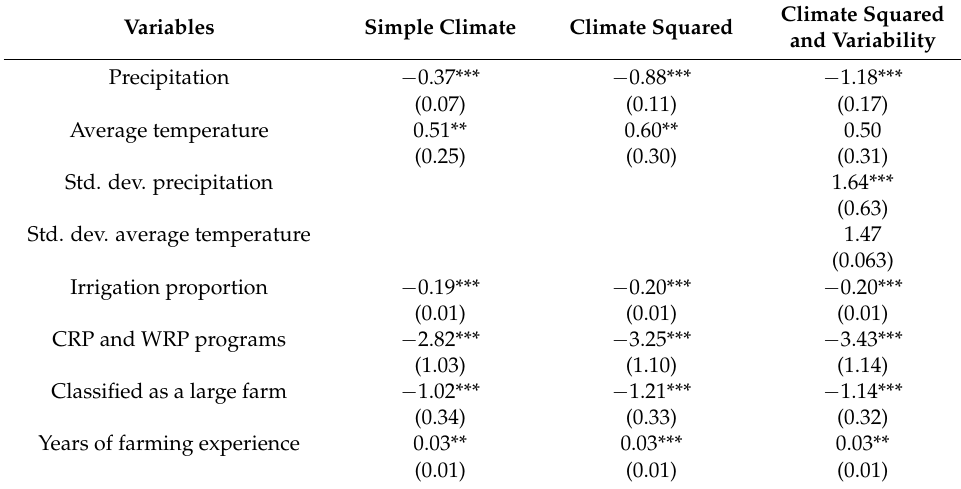
Table 2. Estimated marginal effects on fallow share for three model specifications (Unit: